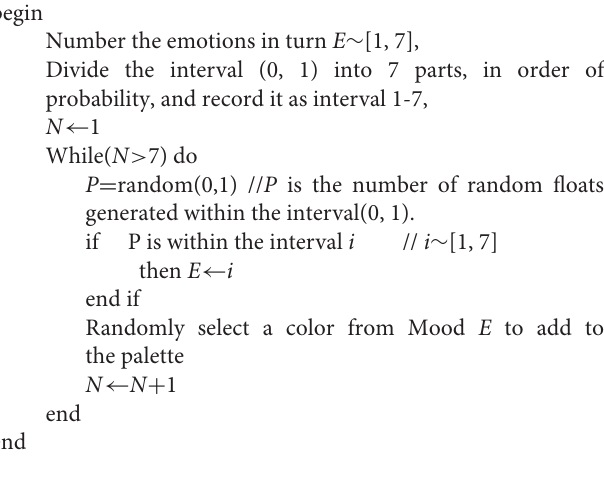
Algorithm 1 | The adopted model in this